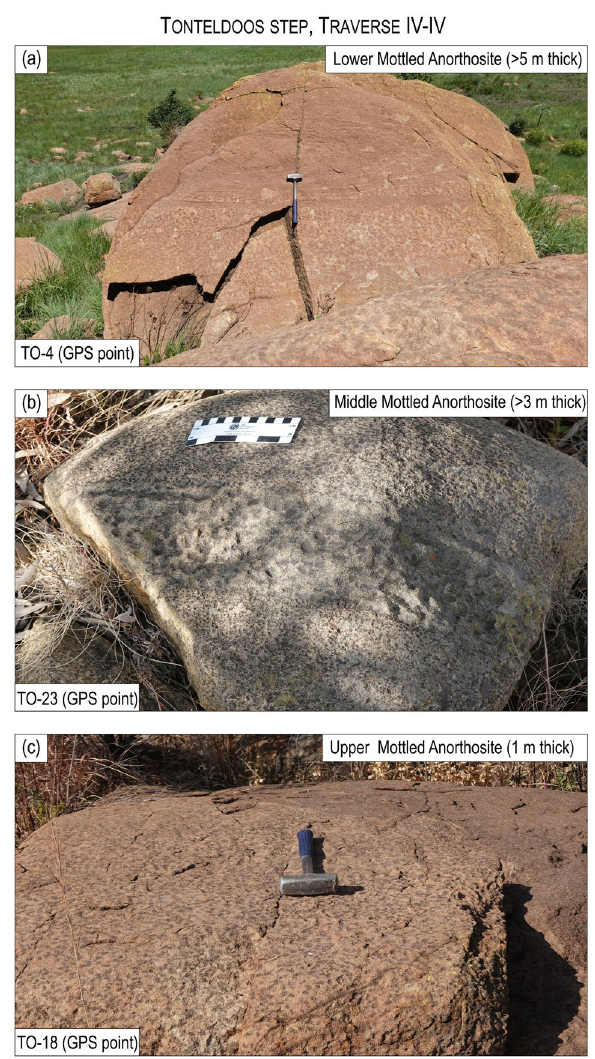
Figure 4. Photos of field outcrops of the three Anorthosite Markers along the traverse IV-IV at the Tonteldoos step of the Roossenekal sub-chamber of the southeastern part of the Bushveld Complex. All photos were taken by Sofya